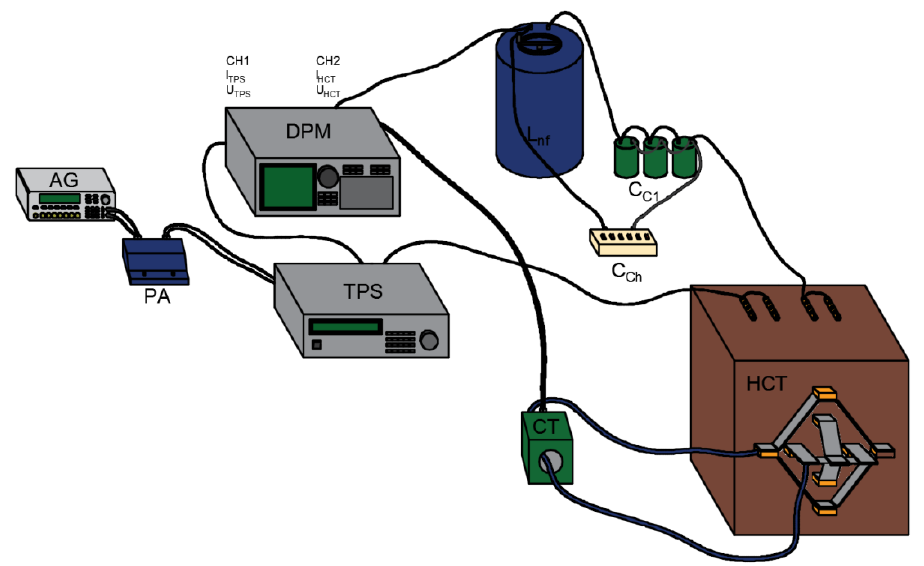
Figure 9. The measuring circuit for determination of the frequency band of operation of the power sources for the required rms values of the higher harmonics of the output current.